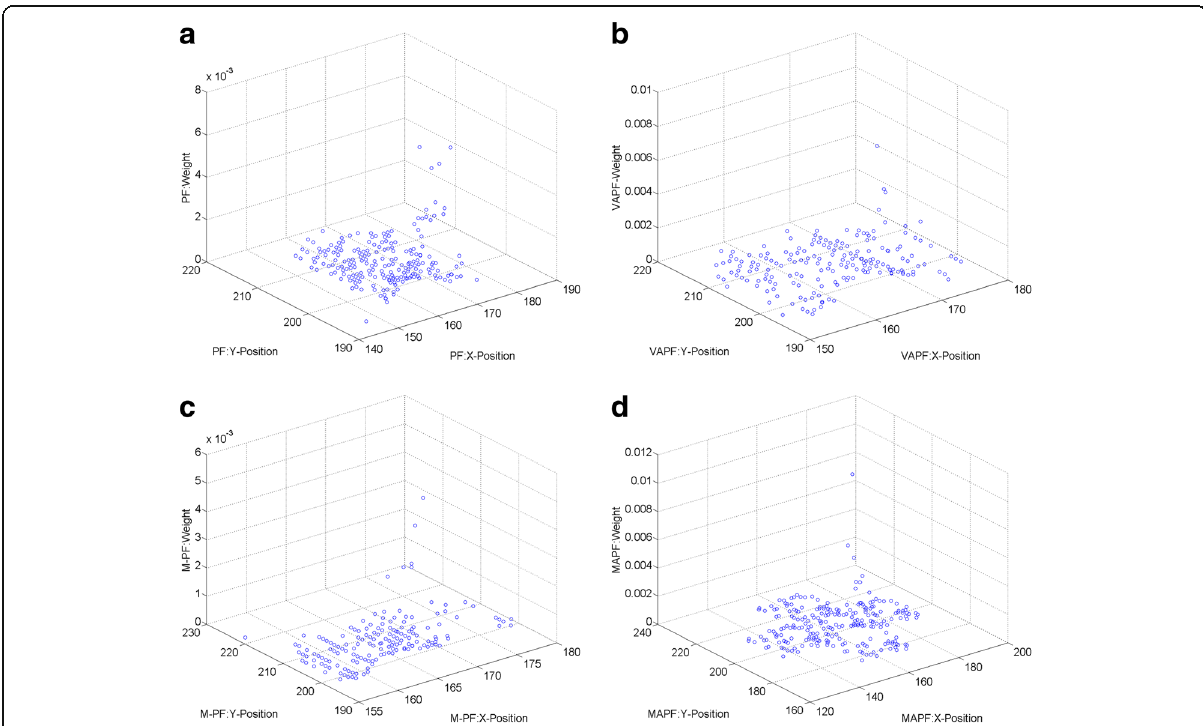
Fig. 8 Particle weights distribution of the 7th frame of video “ tennis ” using different algorithms, PF(a), VAPF(b), M-PF(c) and Proposed(d)